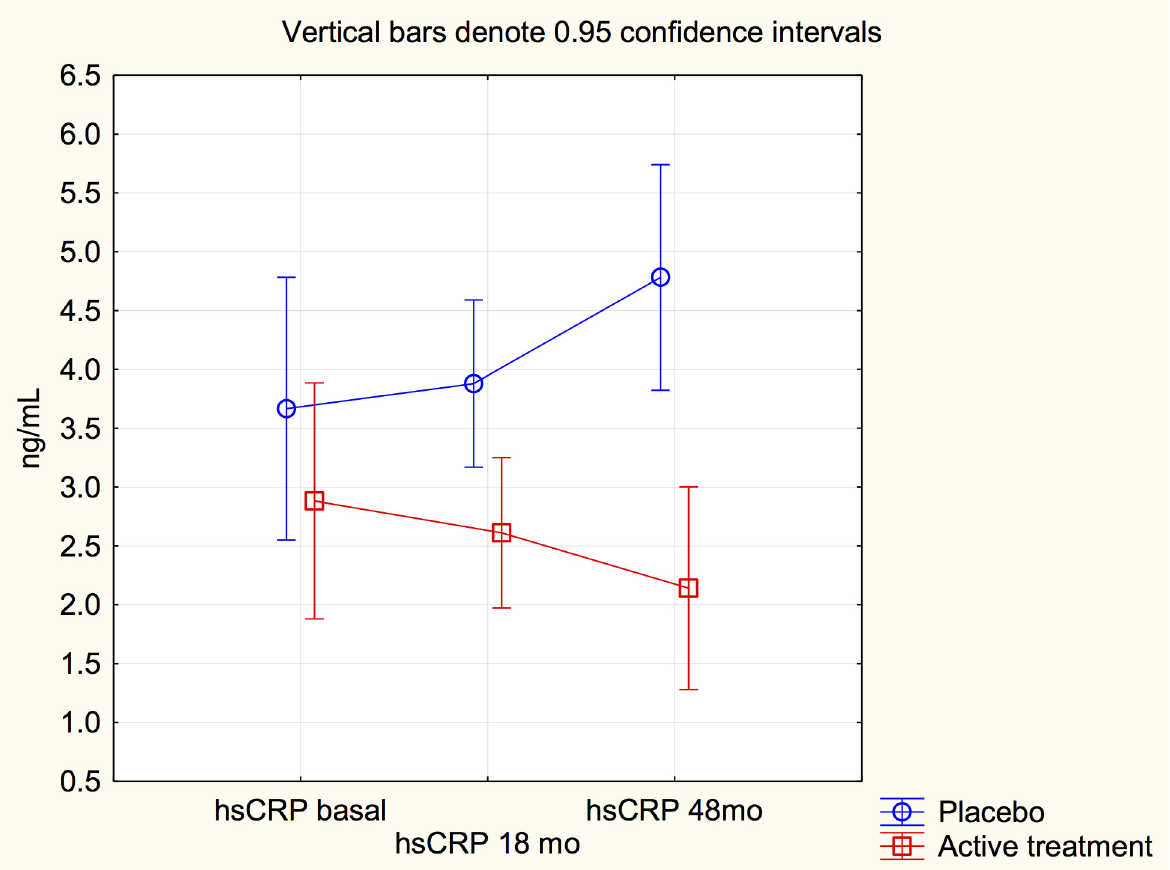
Fig 2. Graph illustrating C-reactive protein measurements at study start, after 18 months and at study stop at 48 months in the study population given selenium and coenzyme Q10 combined, or placebo. Note: Analysis according repeated measures of